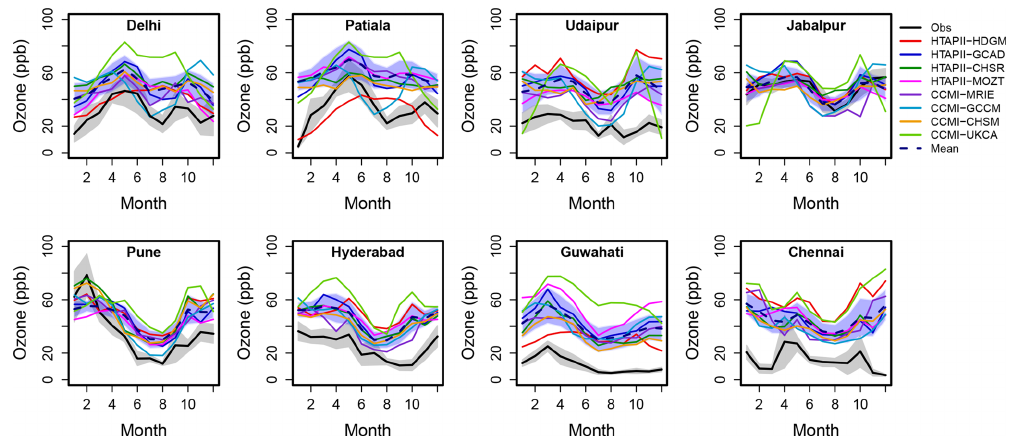
Figure 5. Comparison between ground-based observations, model-simulated data and the ensemble mean of monthly mean surface ozone over the eight MAPAN stations.